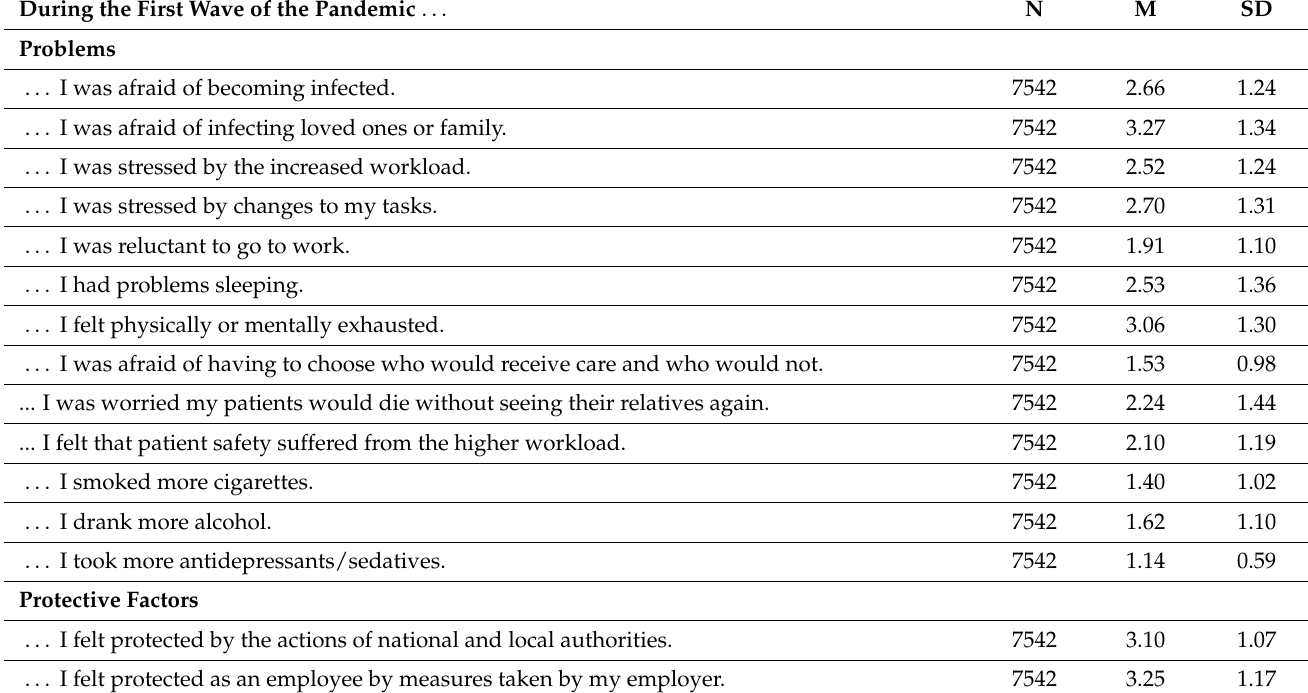
Table 2. Problems and protective factors associated with